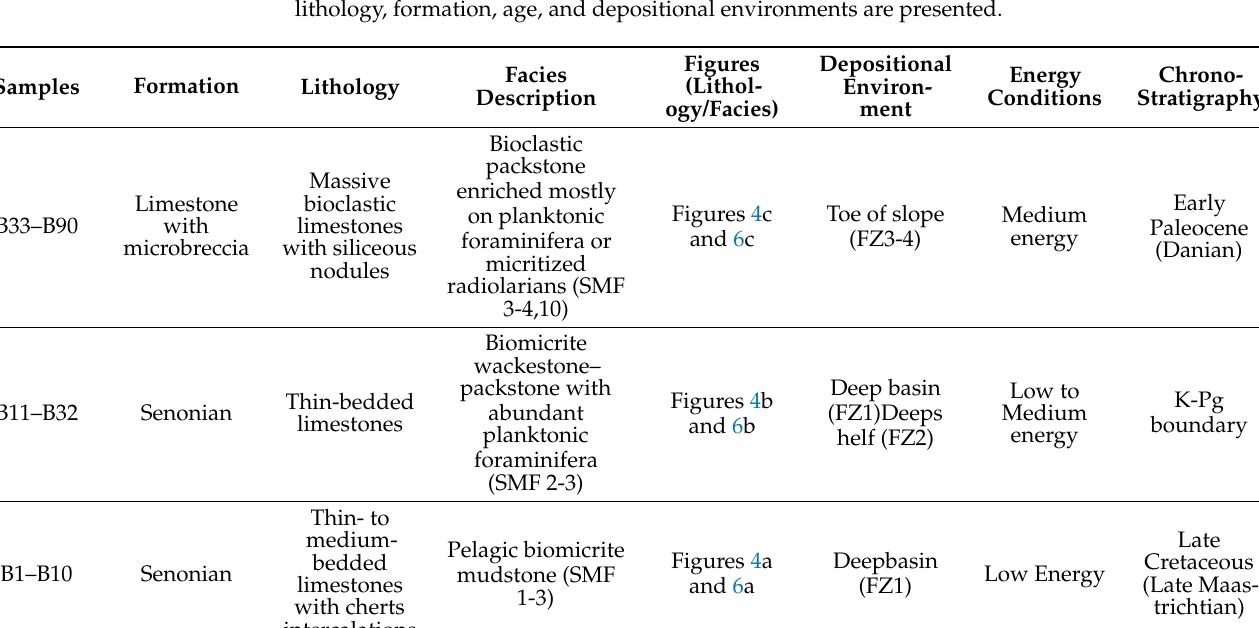
Figure 5. Reddish to brownish chert horizons. Siliceous nodules appear in a variety of shapes, mostly ( a ) sub-spherical, ( b ) elongated-to-flattened, or ( c ) mushroom types. Table 1. Detailed description of the analyzed samples (thin sections), where depositional facies, lithology, formation, age, and depositional environments are